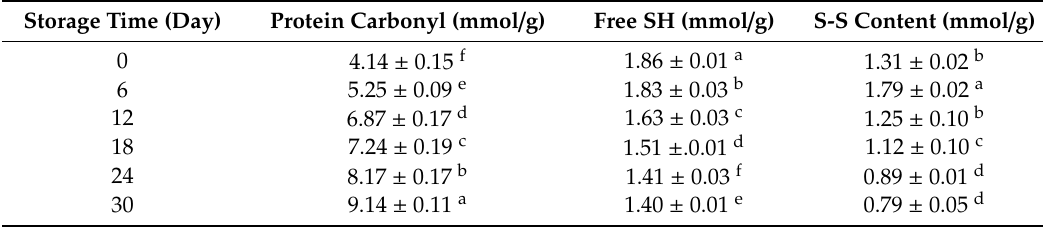
Table 1. Protein oxidation markers in soy protein isolate (SPI) with di ff erent storage